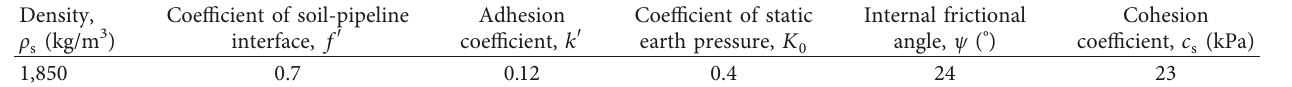
Table 4: Physical and mechanical parameters of the soil around